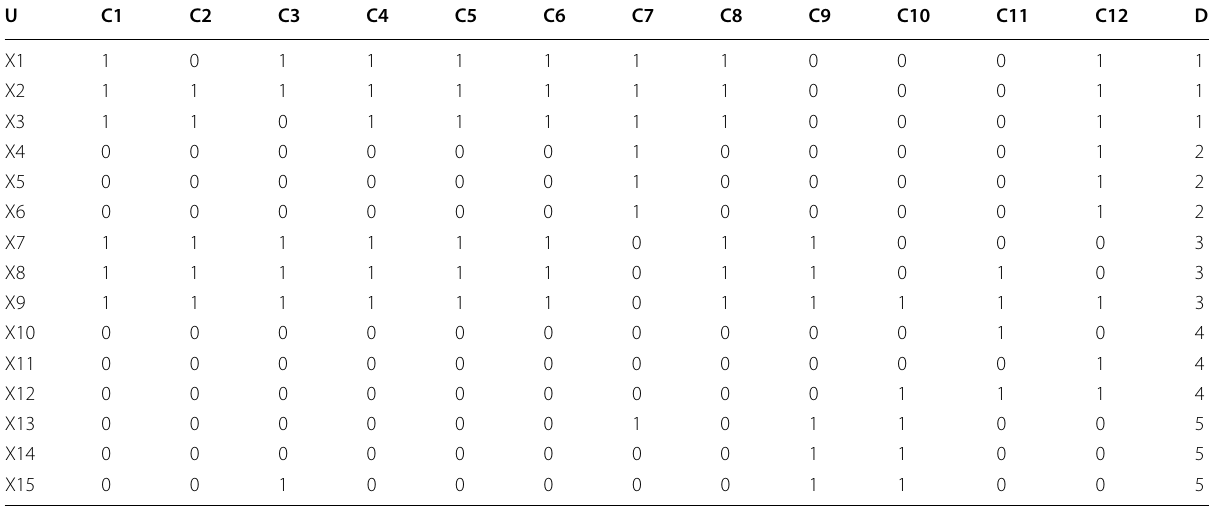
Table 4 Discrete decision table of fault features